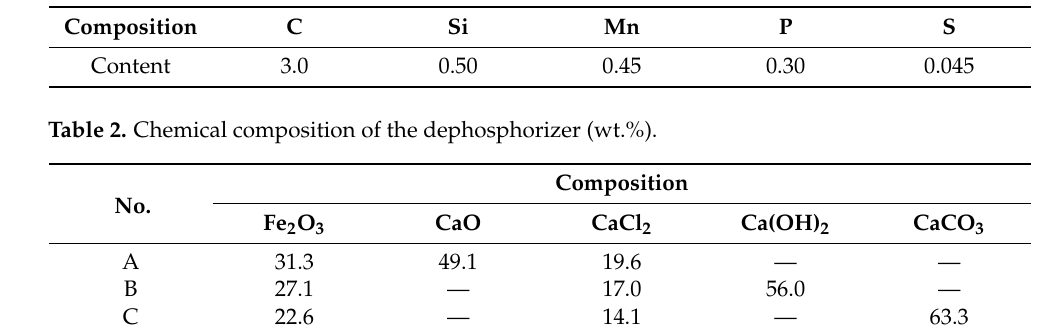
Table 1. Chemical composition of the pig iron powder (wt.%).